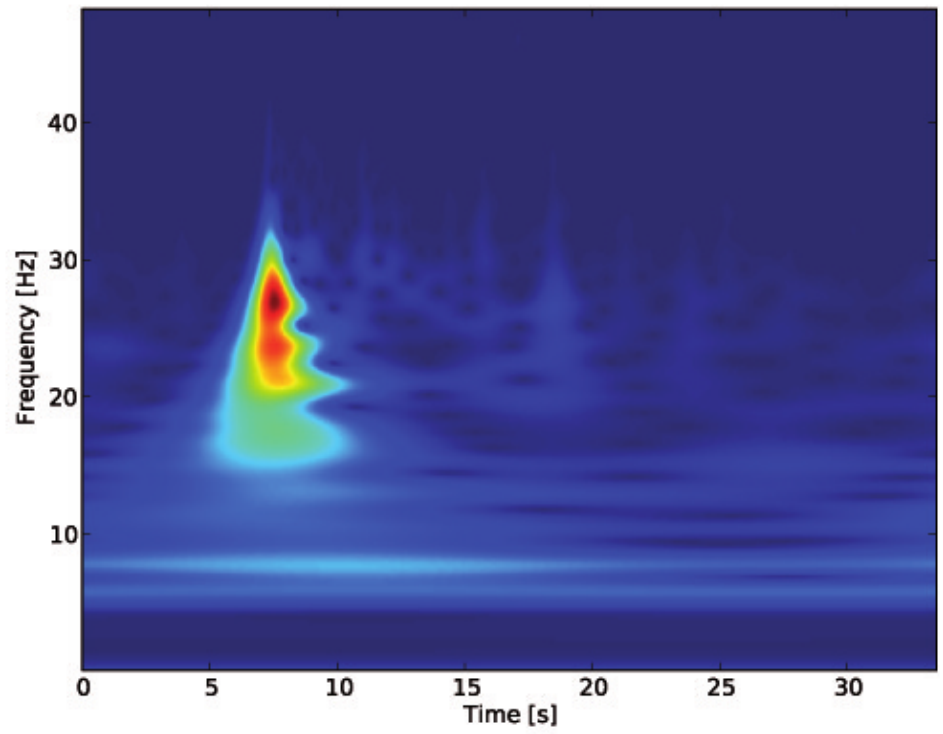
Figure 5. The result of the continuous wavelet transform. Bluish colors represent low energy, reddish colors represent high